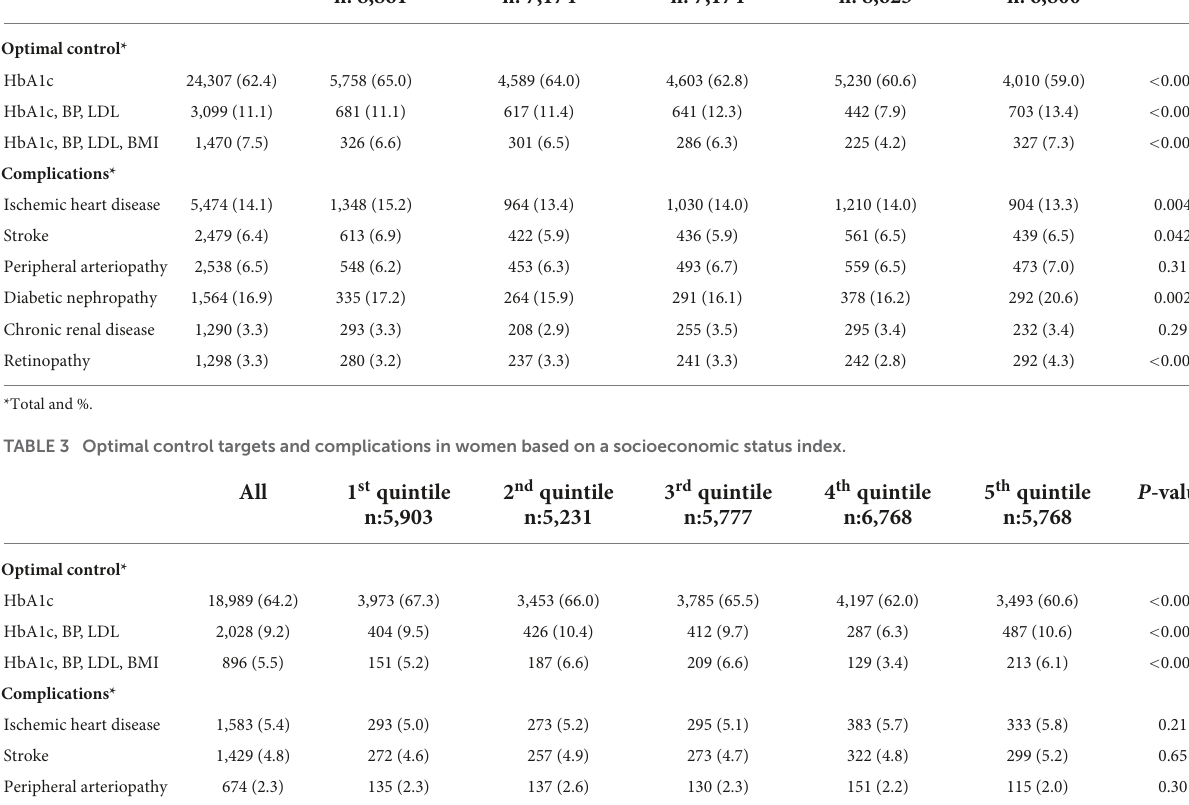
TABLE 2 Optimal control targets and complications in men based on a socioeconomic status index. All